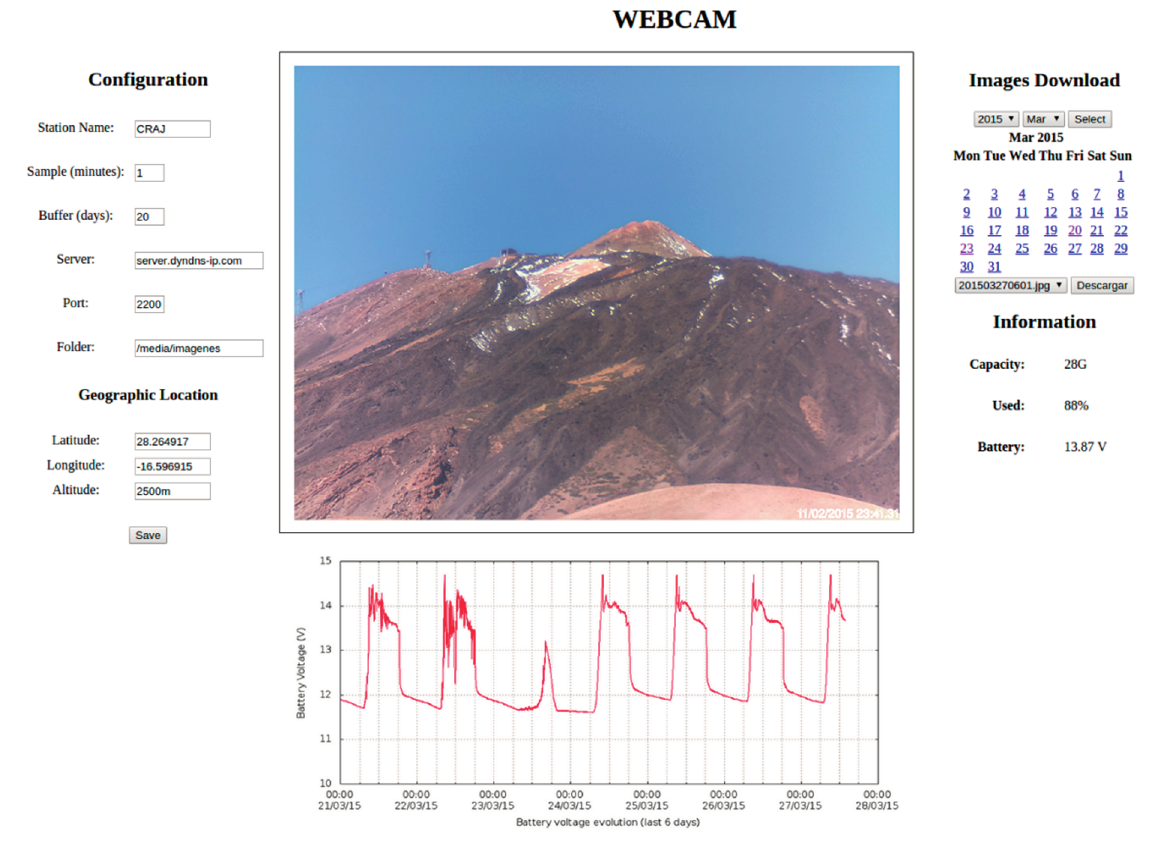
Figure 9. Left-hand side: the system configuration; center: the most recent picture of Teide Volcano (Tenerife) taken from a distance of approximately 4 Km and a graph of the evolution of the battery; right-hand side: information about the system, as well as the option for downloading images using a